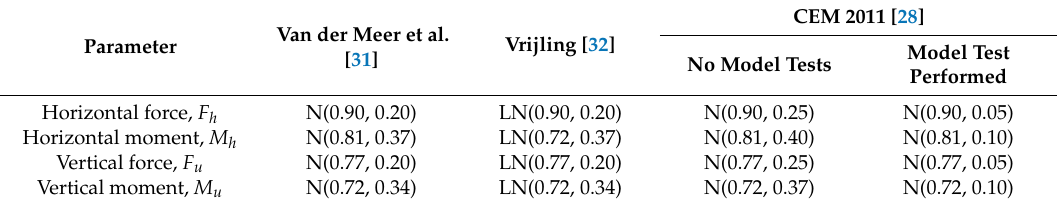
Table 3. Statistical properties of reduced factor applying to Goda’s